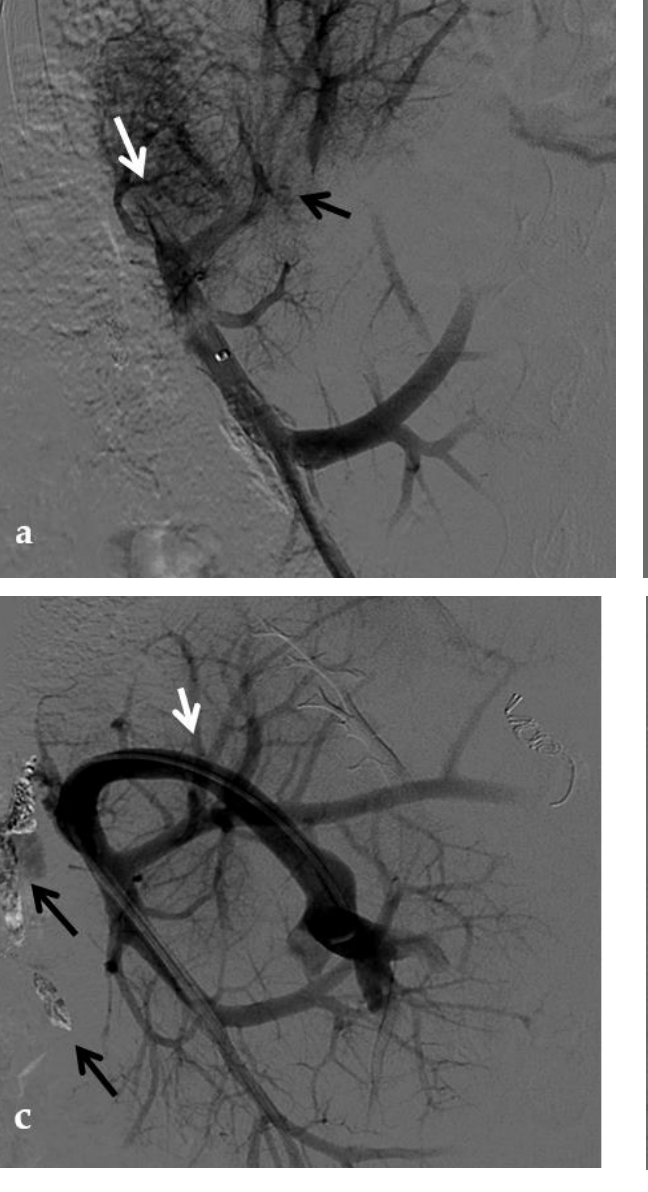
Figure 10. Anteroposterior view of a percutaneous transhepatic portography imaging series in the same patient as in Figure 9. ( a ) Portography image shows recurrence of complete extrahepatic portal vein thrombosis (white arrow) 1 year after the first angioplasty treatment. Flow reversal in the segment 2 portal branch resulting from portal cavernoma is still evident (black arrow). ( b ) After transhepatic portal vein recanalization with the angiographic catheter, the splenic portogram shows jejunal cavernoma (white arrows) and gastric (black arrow) varices, due to complete obstruction of the extrahepatic portal trunk. Embolization of varices was performed using a mixture of N-butyl cyanoacrylate and iodized oil and metallic coils. ( c ) Portography image after angioplasty of the extrahepatic portal vein shows successful endoluminal filling of the portal vein, with a restored but still irregular profile (white arrow). Note subtraction artifacts (black arrows) representing lipiodol and coils in the cavernoma and varices. ( d ) Final portogram performed after deployment of a 10-mm self-expandable bare metal stent to treat residual stenosis of the extrahepatic portal vein; the main portal vein is now regularly opacified with adequate size and both intrahepatic portal branches present hepatopetal flow.